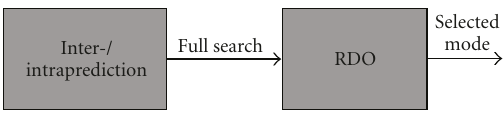
Figure 2: Conventional inter mode prediction in the